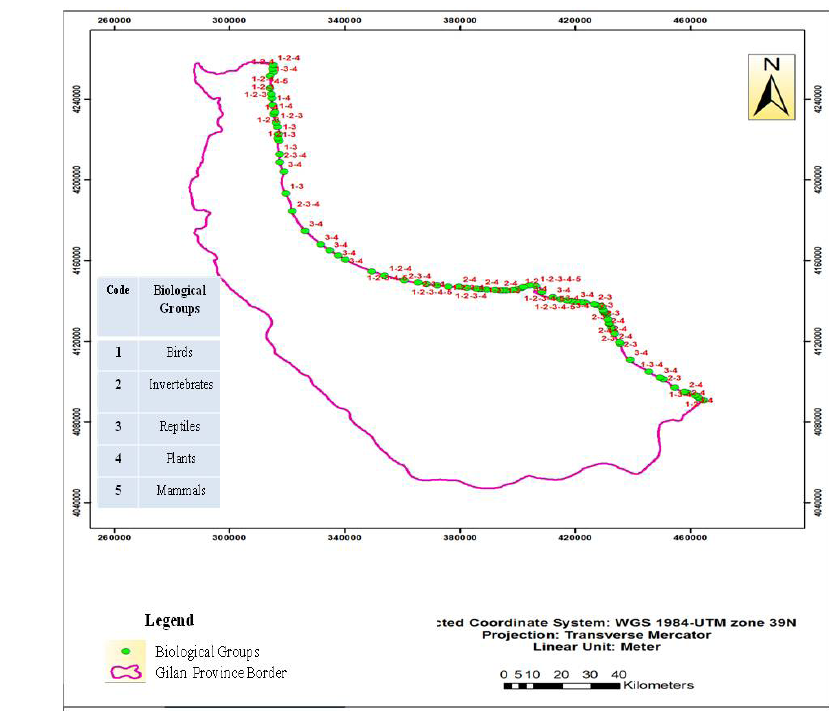
Figure 2. The map of the biological groups locations on the coastline